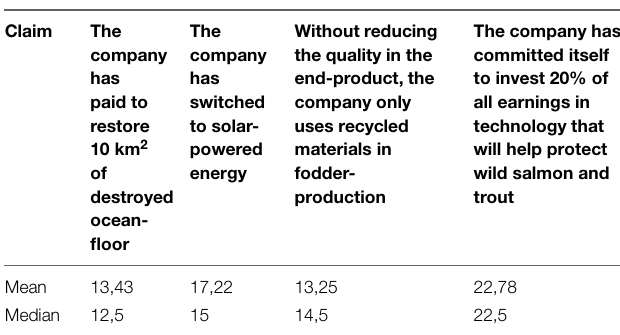
TABLE 1 | Evaluation of positive claims.